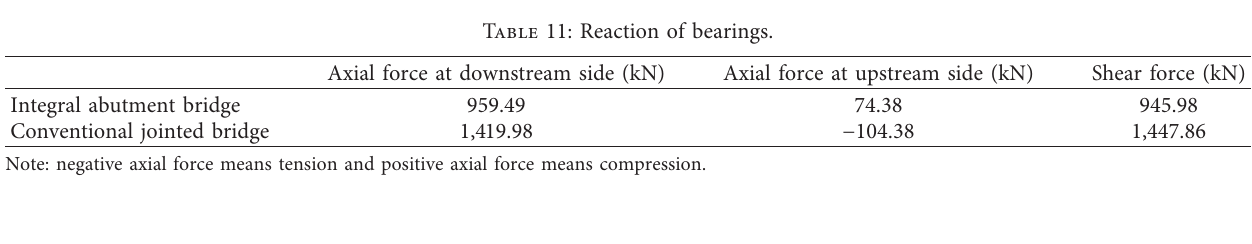
Table 12: Internal force of the piers.